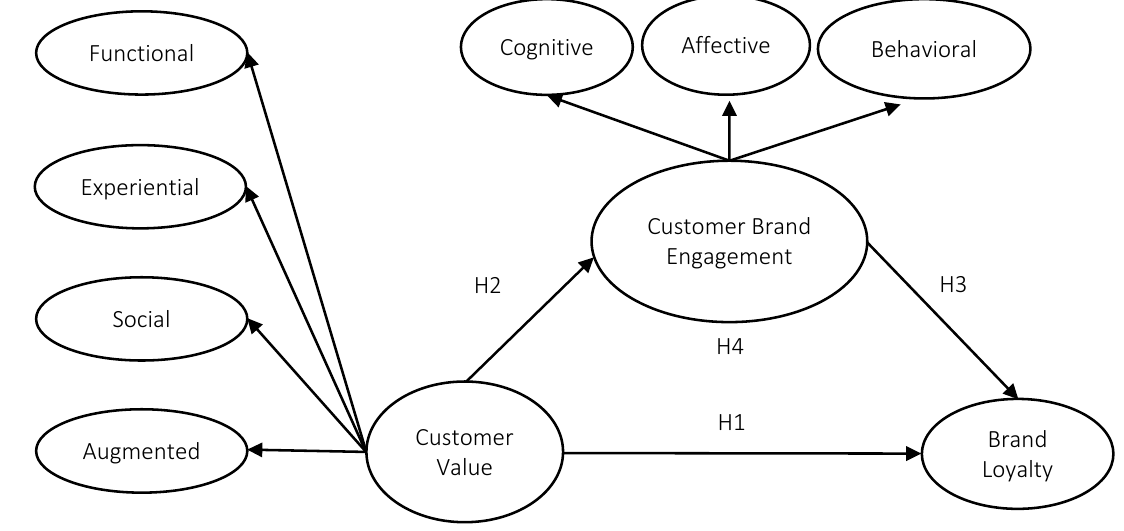
Figure 1. Conceptual